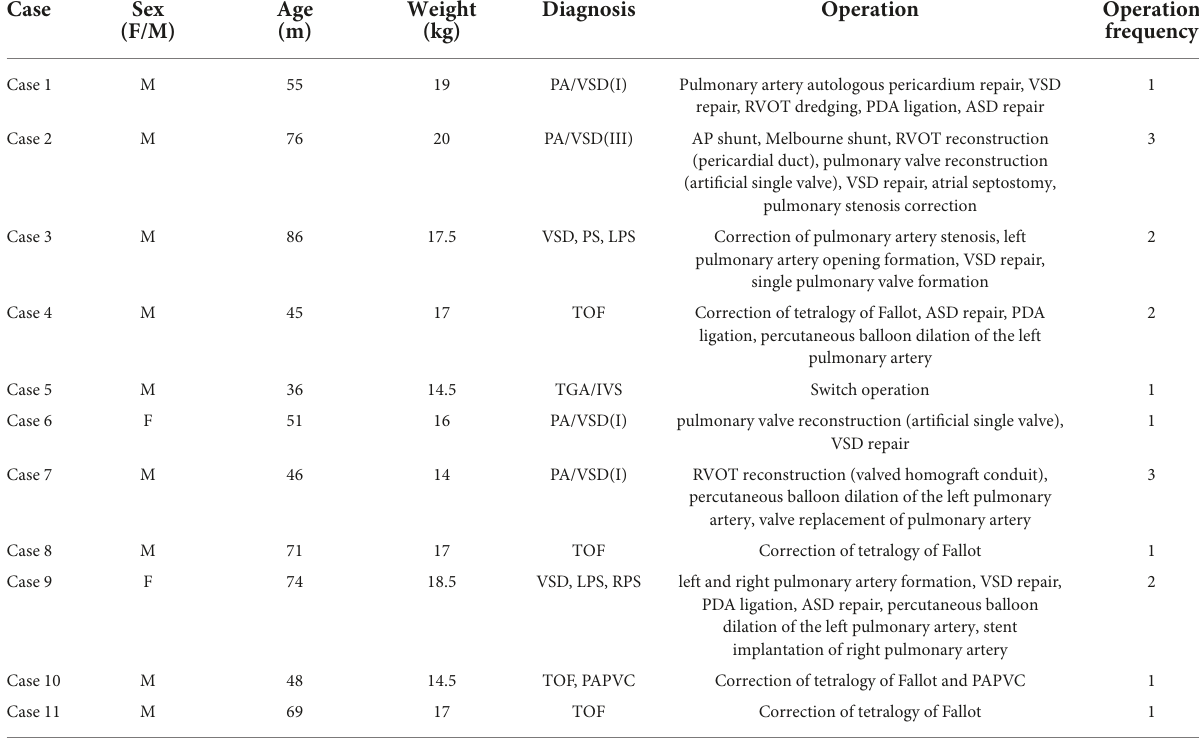
TABLE 1 Clinical characteristics.